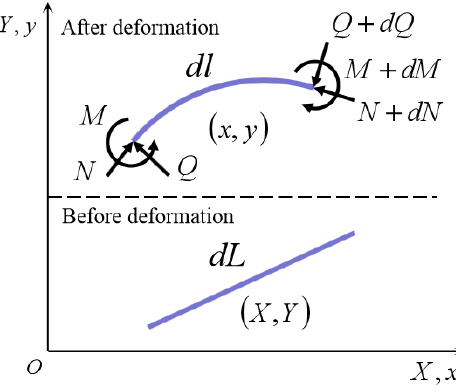
Figure 2. Deformation and internal forces in the ligament beam.